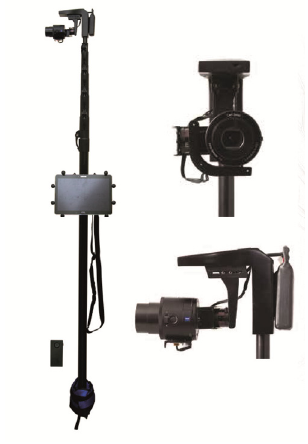
Figure 7. The 3D EYE system